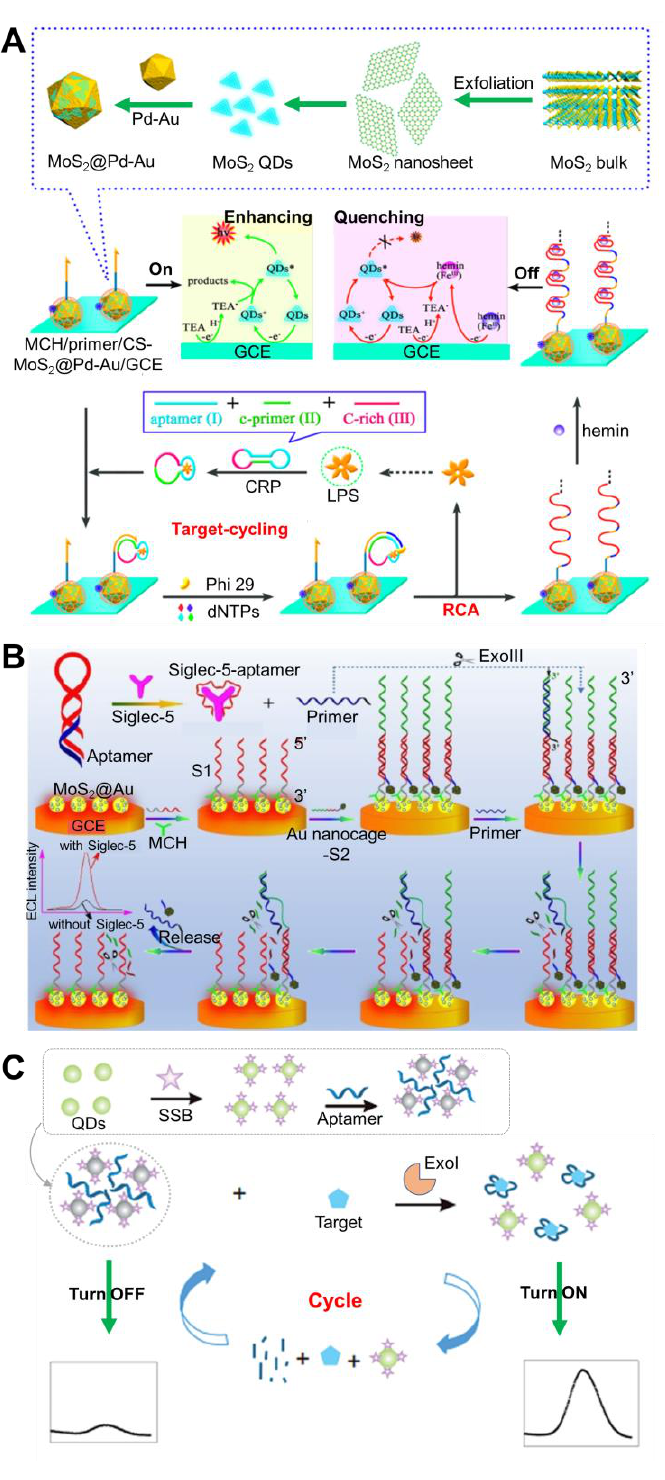
Figure 4. Quantum dot (QD) biosensing strategy based on change in signal emission of QD by DNA-modifying enzyme-assisted reaction. ( A ) Aptamer-driven target-cycling synchronized rolling circle reaction-coupled MoS 2 QD@Pd-Au composite biosensor for detection of lipopolysaccharide (LPS). Reproduced with permission from [49]; ( B ) exonuclease III (ExoIII)-based signal amplification reaction-coupled MoS 2 QD@Au composite biosensor to detect LPS. Reproduced with permission from [50]; ( C ) exonuclease I (ExoI)-aided target recycling reaction-coupled MoS 2 QD@Au composite biosensor to detect streptomycin. Reproduced with permission from [51]. GCE, glassy carbon electrode; TEA, trimethylamine; CRP, circular recognition probe; dNTP, deoxyribonucleoside triphosphate; RCA, rolling circle amplification; MCH, mercaptohexanol.